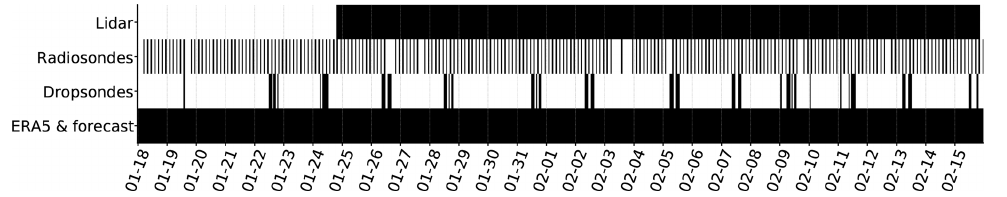
Figure 3. Overview of the temporal coverage of different observational datasets from EUREC 4 A which are used in this study. A black stripe indicates the availability of data for the corresponding